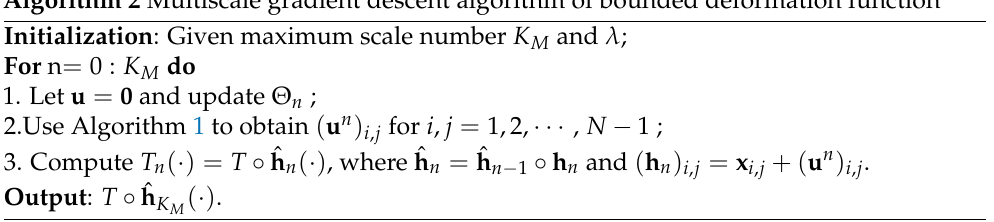
Algorithm 2 Multiscale gradient descent algorithm of bounded deformation